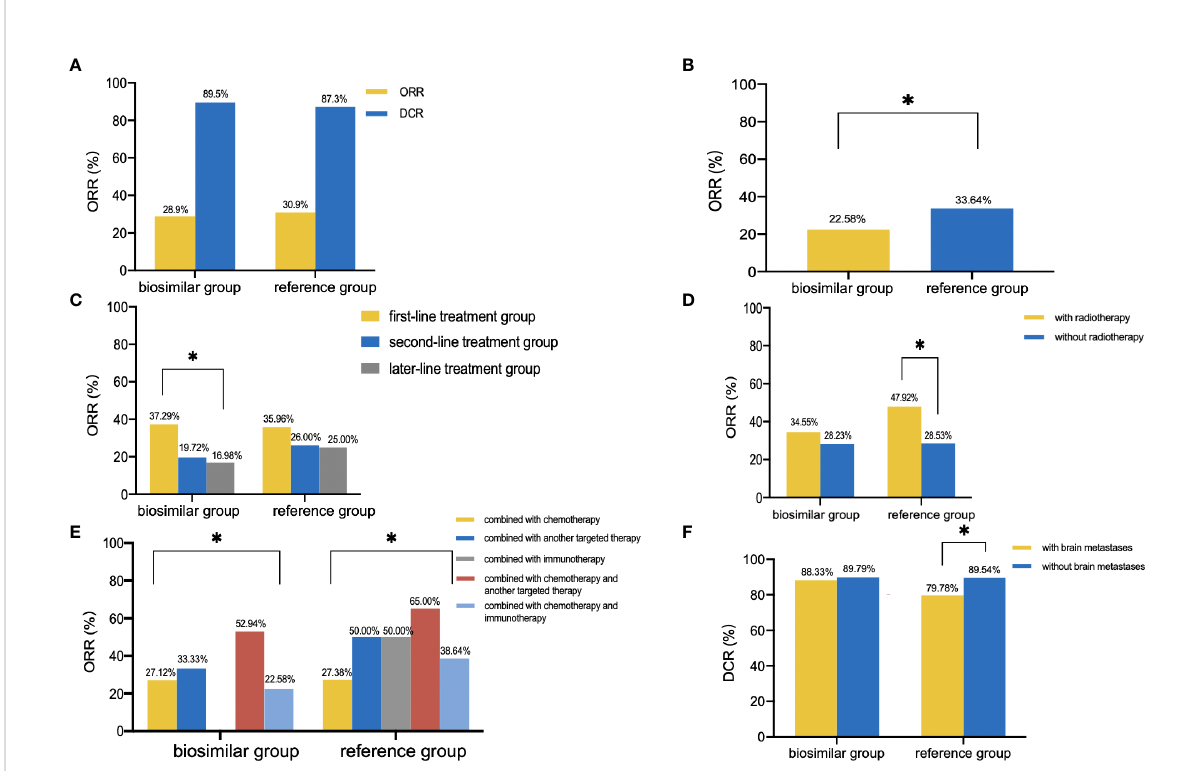
FIGURE 1 Clinical outcomes. (A) , ORR and DCR of the biosimilar and reference groups. (B) , ORR of patients treated with bevacizumab (or biosimilar) in combination with chemotherapy and immunotherapy. (C) , ORR of different number of treatment lines in the two groups. (D) , ORR of patients with or without radiotherapy in the two groups. (E) , ORR of different combined treatment regimens in the two groups. (F) , DCR of patients with or without brain metastases in the two groups. * P